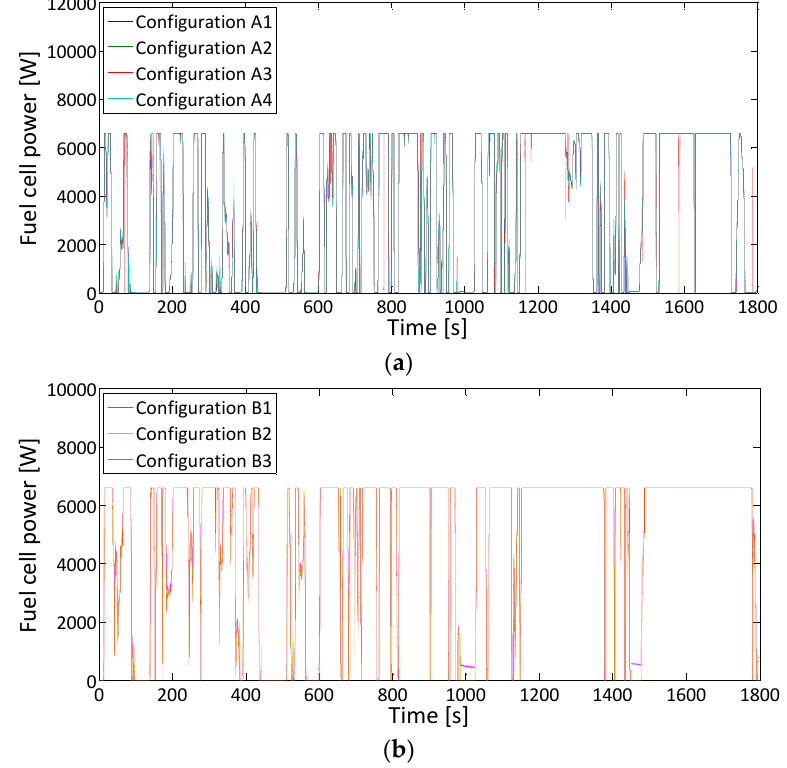
Figure 11. ( a ) Fuel cell output power under Configurations A1–A4; ( b ) Fuel cell output power under Configurations B1–B3.